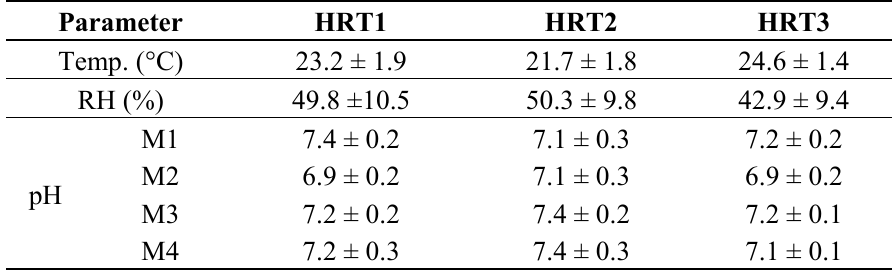
Table 1. Mean values (± SD a n = 40) of temperature (Temp.) and relative humidity (RH) for environmental conditions and pH in every sampling